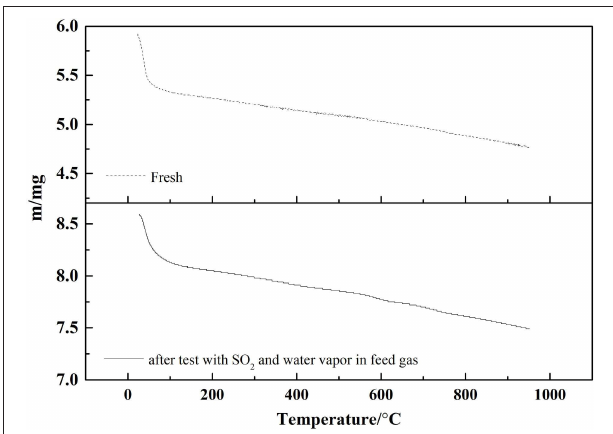
FIGURE 14 | TG curve of catalyst before and after